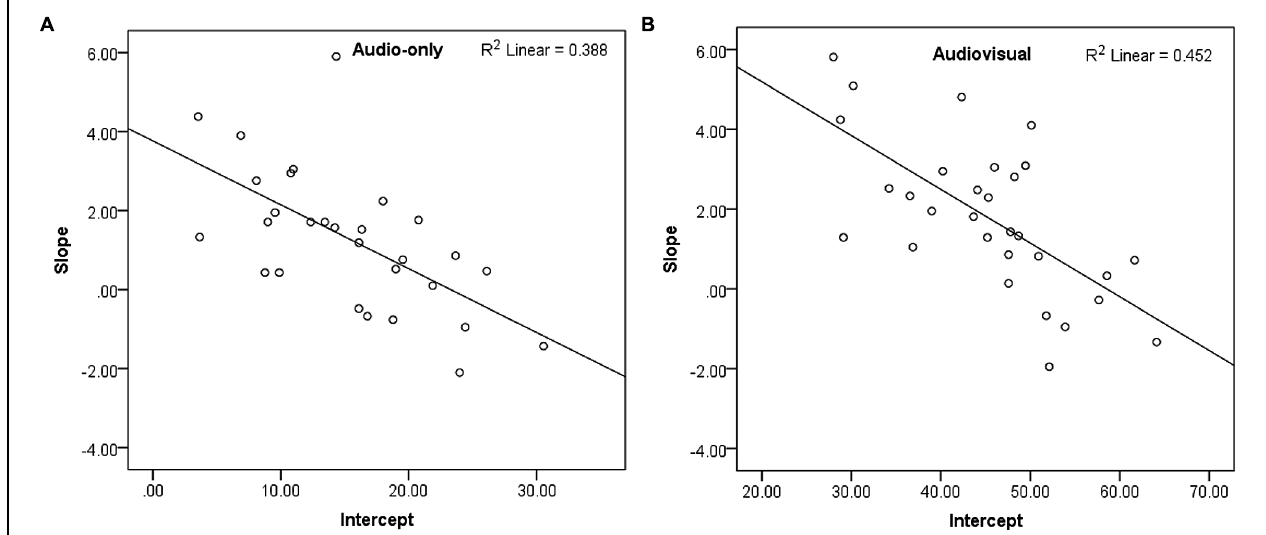
FIGURE 6 | (A,B) Scatterplots showing slope (adaptation) and intercept (baseline recognition accuracy) for recognition of the accented speech in Study 2, per group and with linear fit.